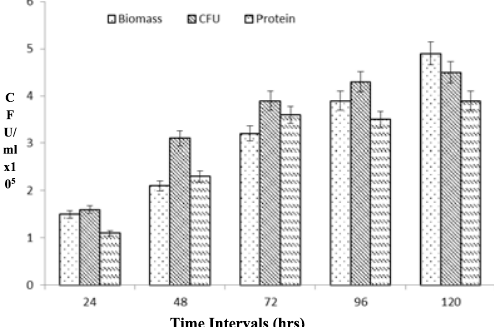
Fig. 3. Pattern of biomass, colony forming unit and protein contents in the pulp paper industry effluent after biostimulation